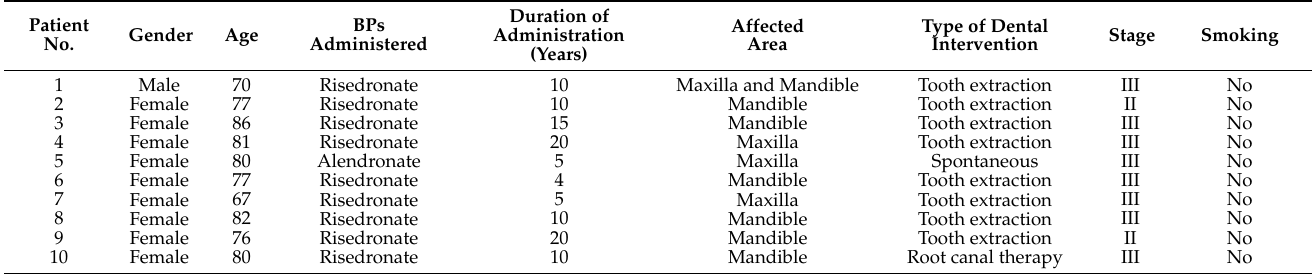
Table 1. Clinical characteristics of patients with